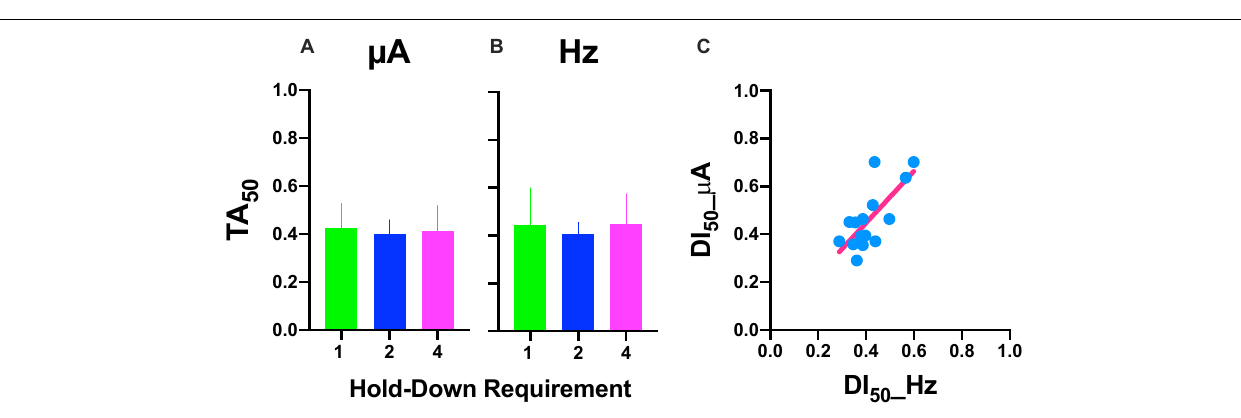
FIGURE 10 | DI 50 after intensity (A) or frequency (B) variations. Mean ± SE (5 subjects). (C) Relationship between DI 50 observed after variations in frequency or intensity. Each point is the DI 50 of each rat plotted in common units (see text) at different prices (hold-down requirement).